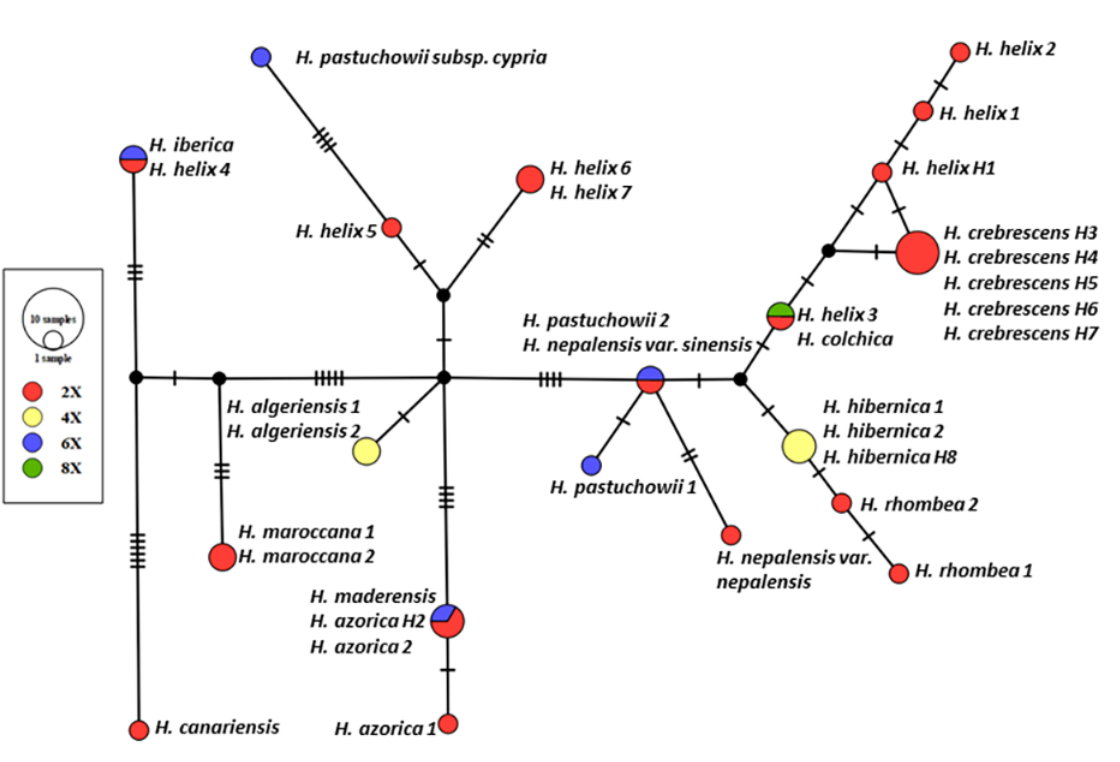
Figure 2 The haplotype network obtained based on Templeton–Crandall–Singh analysis of five concatenated cpDNA regions of Hedera samples. Black dots indicate missing intermediate haplotypes that were not observed in the analyzed sample set. Hash marks on branches represent mutation steps (number of base pair changes) between haplotypes. The different colors indicate the ploidy levels (red = 2 x , yellow = 4 x , blue = 6 x , and green = 8 x